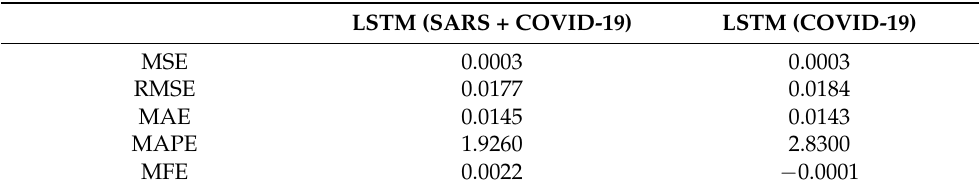
Table 16. The Value of Each Measure for the COVID-19 Period with Five-Day-Ahead Forecast.